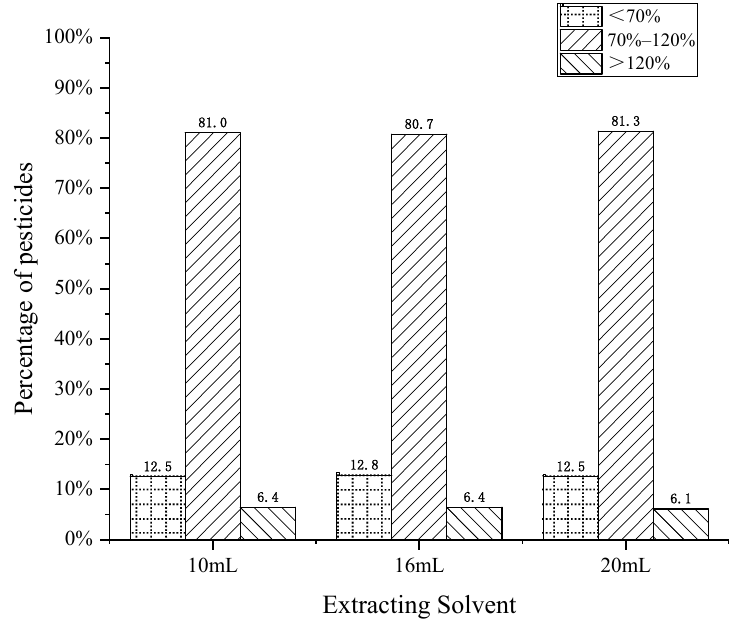
Figure 2. Effect of extraction solvent volume on pesticide recovery.